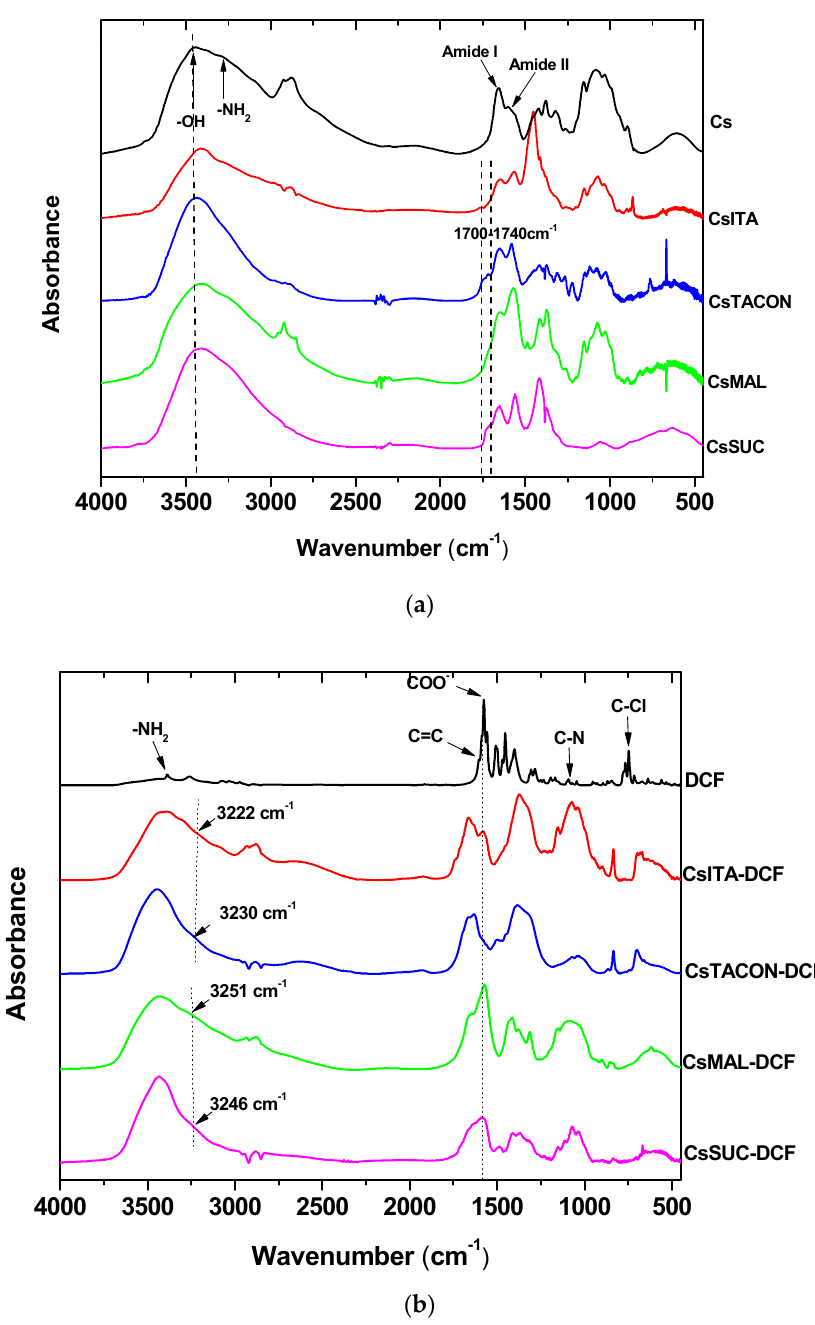
Figure 4. FTIR spectra of the synthesized chitosan derivatives: ( a ) before cross-linking in comparison with neat CS; ( b ) after cross-linking and DCF adsorption.